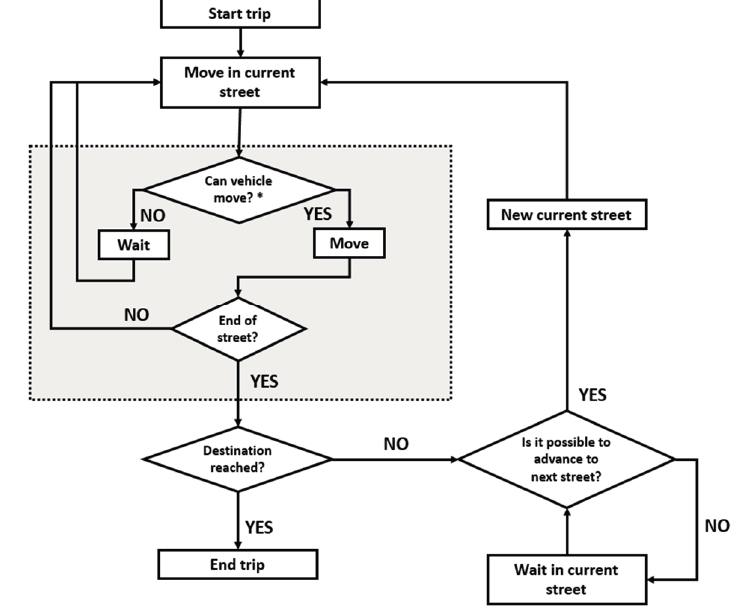
Figure 19. Vehicle movement